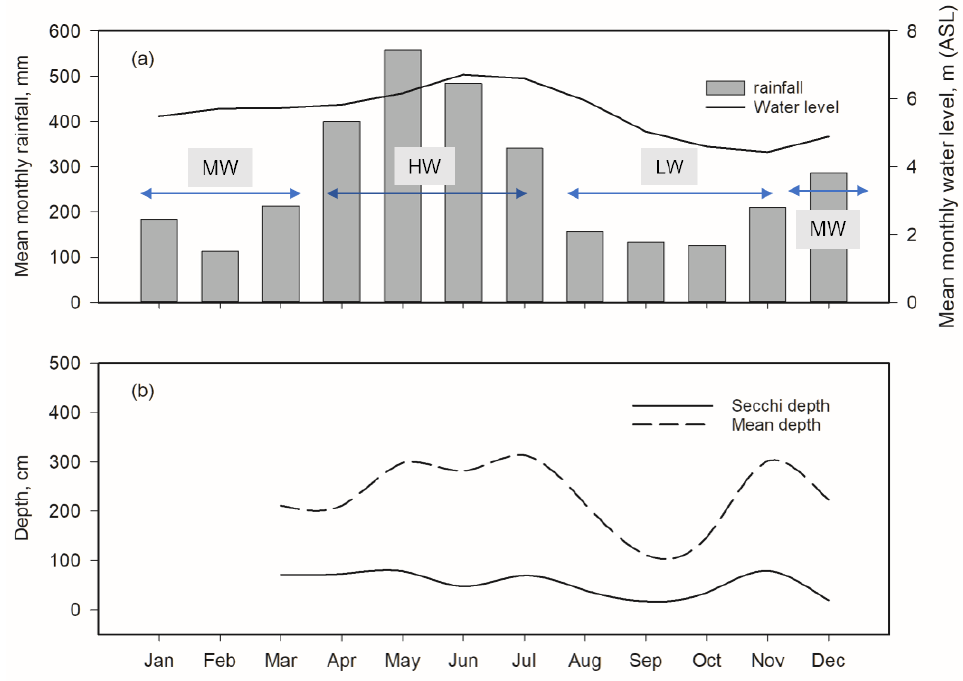
Figure 2. Monthly variability of the hydrological characteristics of Lake Tempe. ( a ) Rainfall and mean monthly water level based on a 10-year average from 2000 to 2010; ( b ) mean and Secchi depth of the water during the study period from March to December 2016. The three hydrological periods in the lake are moderate-water (MW), high-water (HW), and low-water (LW).